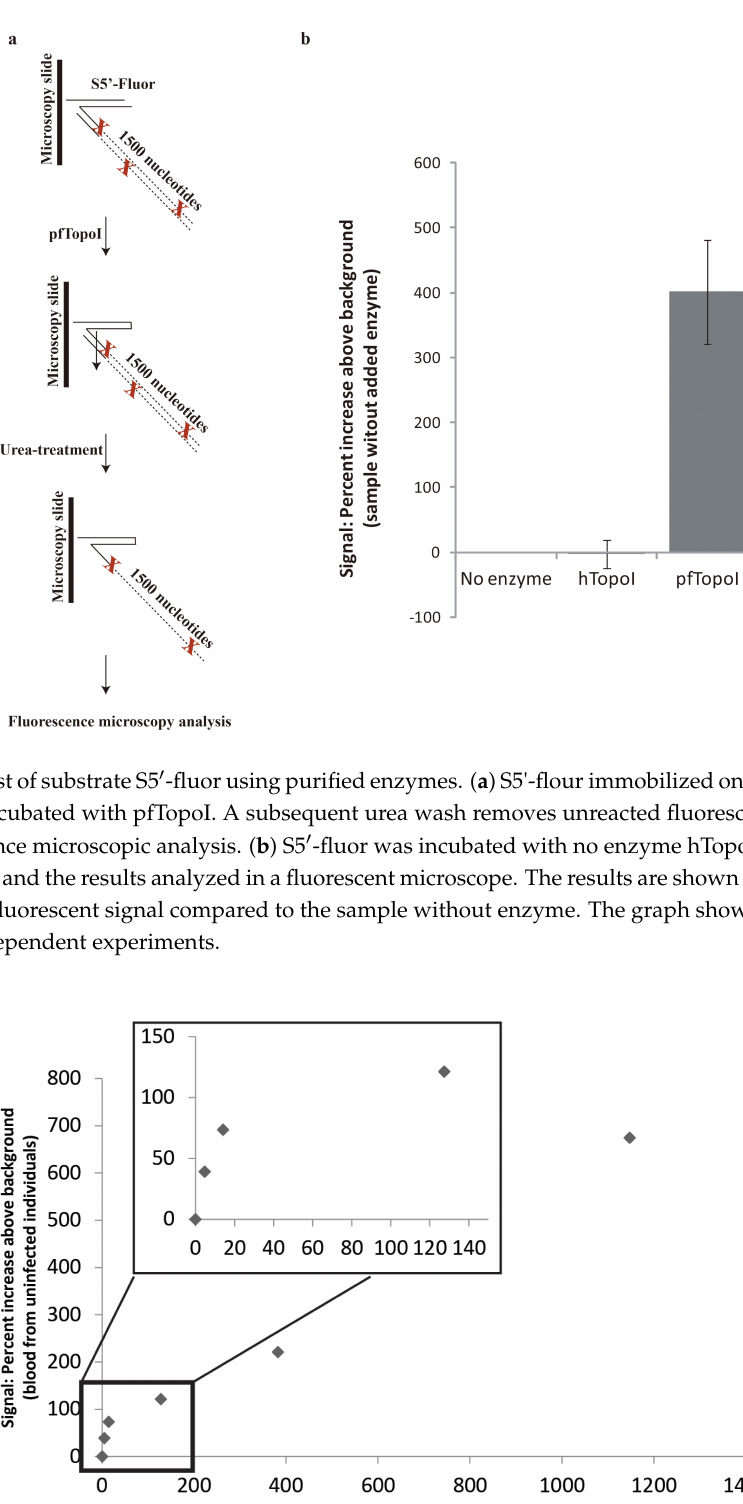
Figure 3. Test of substrate S5'-fluor using blood extracts. S5'-fluor was incubated with extracts prepared from blood with increasing concentrations of P. falciparum as indicated and the results determined by fluorescent microscopy. The results are shown as percent increase in fluorescent signals compared to blood samples negative for plasmodium. The graph shows the average of two independent experiments. The inset zooms in on the lowest parasite concentrations.